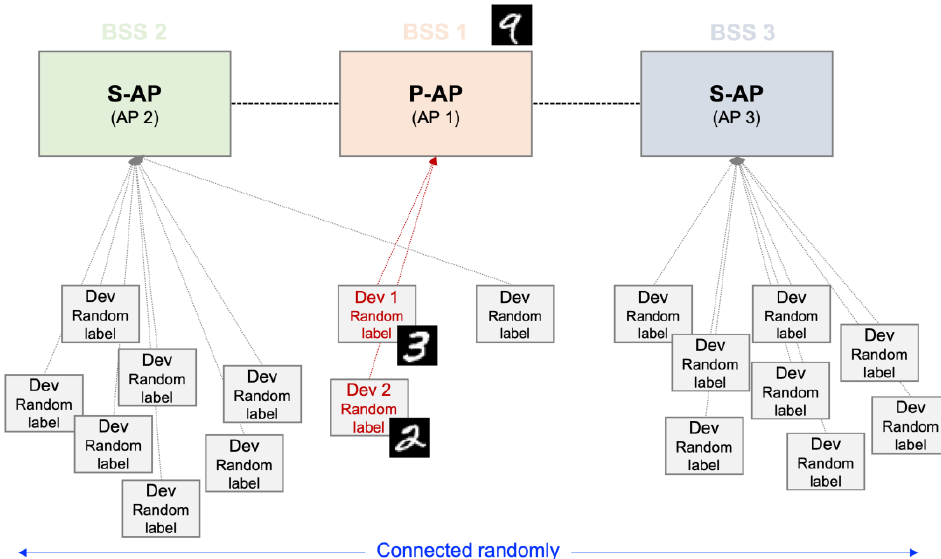
Figure 3. Example of simulation environment. For example, device 1, as Dev 1, has a labeled- “3” and devices 2, as Dev 2, has a labeled- “2” image of the MNIST dataset. To evaluate the accuracy of the new prediction is used the least distributed labeled- “9” image of the MNIST